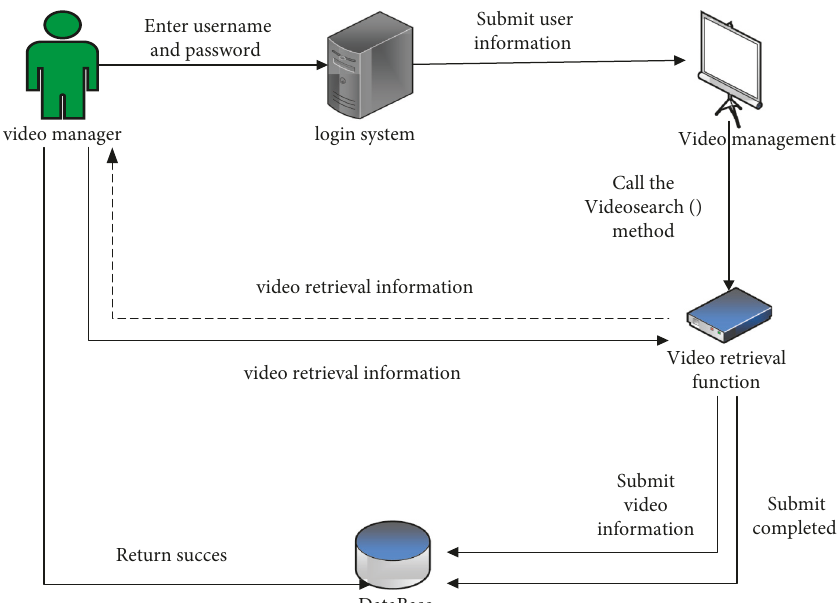
Figure 2: Physical exercise video management module